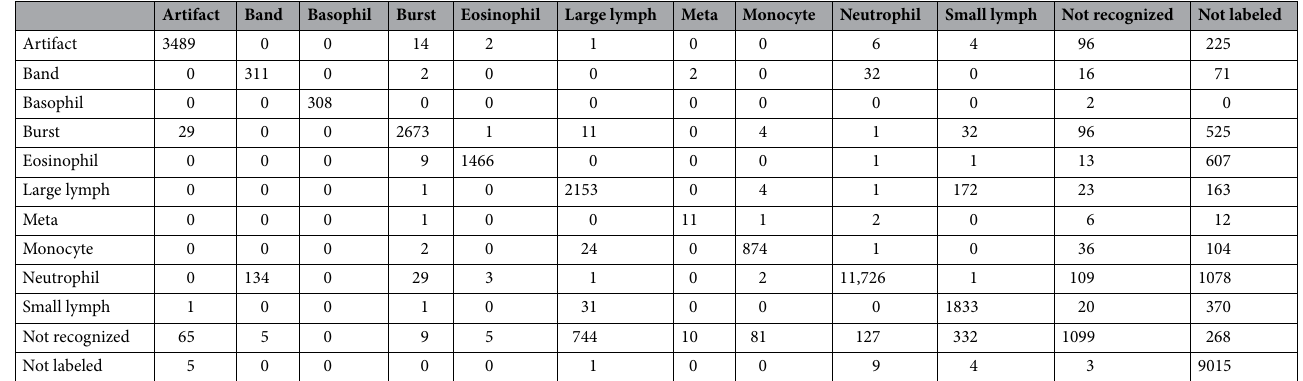
Table 4. The number of labels associated with two experts. The rows and columns belong to the first and second experts, respectively.